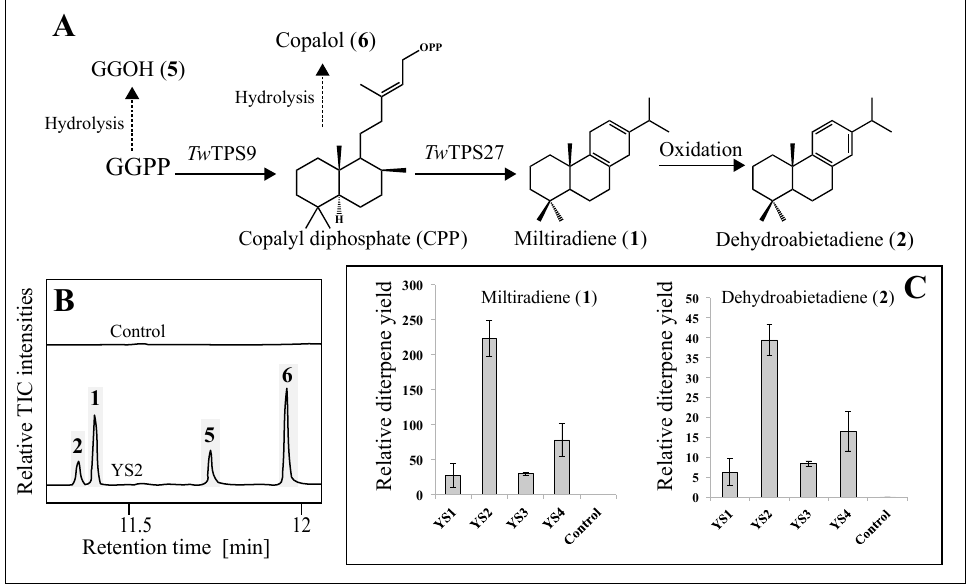
Figure 3. Production of diterpene olefins 1 and 2 in engineered yeast. ( A ) Pathway leading to dehydroabietadiene from GGPPS. Putative hydrolyzed products of GGPP into GGOH ( 5 ) and copalyl-diphosphate (CPP) into copalol ( 6 ) were detected (Figure S1); ( B ) Total ion chromatograms (TIC) of control strain without diTPSs and the strain YS2 expressing codon optimized truncated Tw TPS9 and Tw TPS27; ( C ) Normalized peak areas to cell density of 1 and 2 for all yeast strains. Additional peaks (Figure 3B) with retention time, mass over charge ratio, and fragmentation pattern matching hydrolyzed forms of the intermediates GGPP and CPP, respectively geranylgeraniol (GGOH) ( 5 ) and copalol ( 6 ), were also detected (Figure S1) as well as an unknown compound that co-eluted with 2 (trace amounts insuffiencient for identification, data not shown). Strain YS2 (codon optimized truncated diTPS) showed the highest production capacity of both 1 and 2 . Normalized signal levels corresponding to 1 were 8.1- and 7.3-fold higher in YS2 compared to the lowest producing strains YS1 (codon optimized full length diTPS) and YS3 (full length native